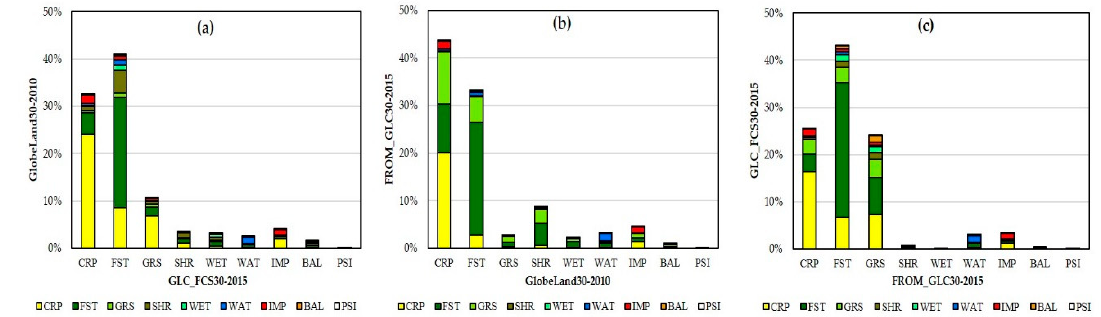
Table 3. Area correlation coefficients between different products.